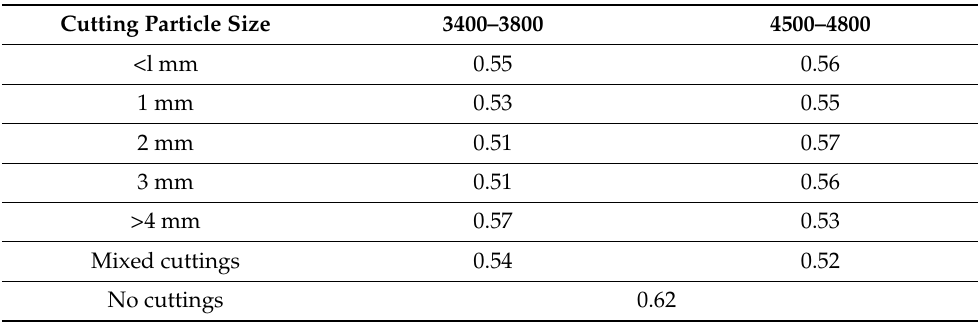
Table 1. Friction coefficient under open-hole rock